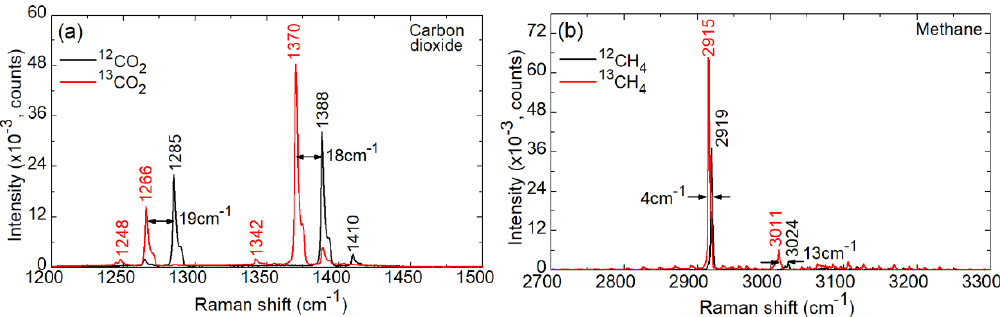
Figure 4. Raman spectra of isotopically enriched ( a ) carbon dioxide ( 12 CO 2 and 13 CO 2 ) and ( b ) methane ( 12 CH 4 and 13 CH 4 ) gases. The excitation wavelength λ exc = 532.123 nm, the resolution is ~1 cm −1 . Gas pressure: 1 atm. Exposure time: 60 s.